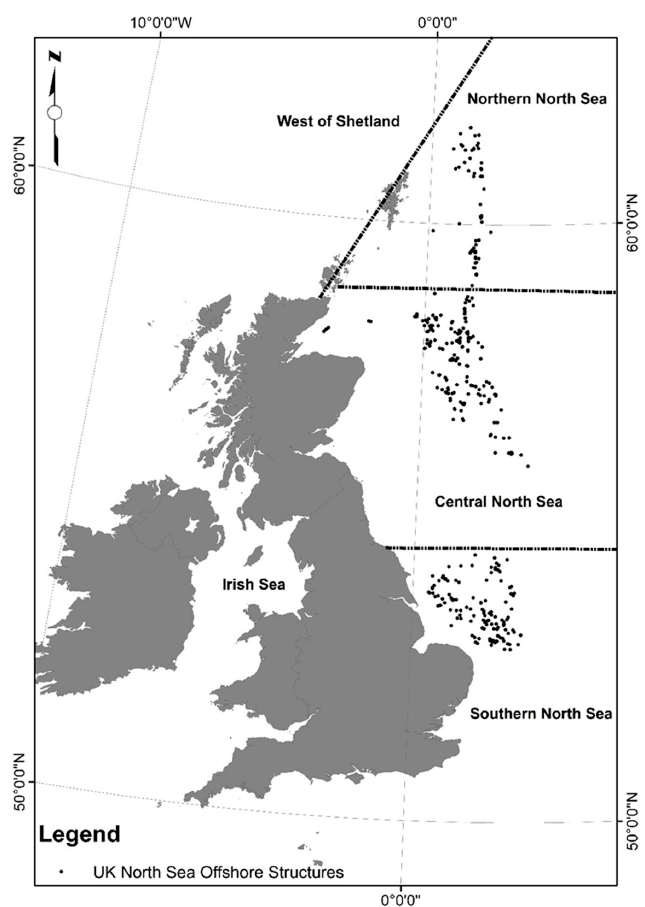
Figure 1. Map of “generally referred” to oil and gas regions in the UK sector of the North Sea (boundaries, dotted line, are approximate and not administratively imposed).